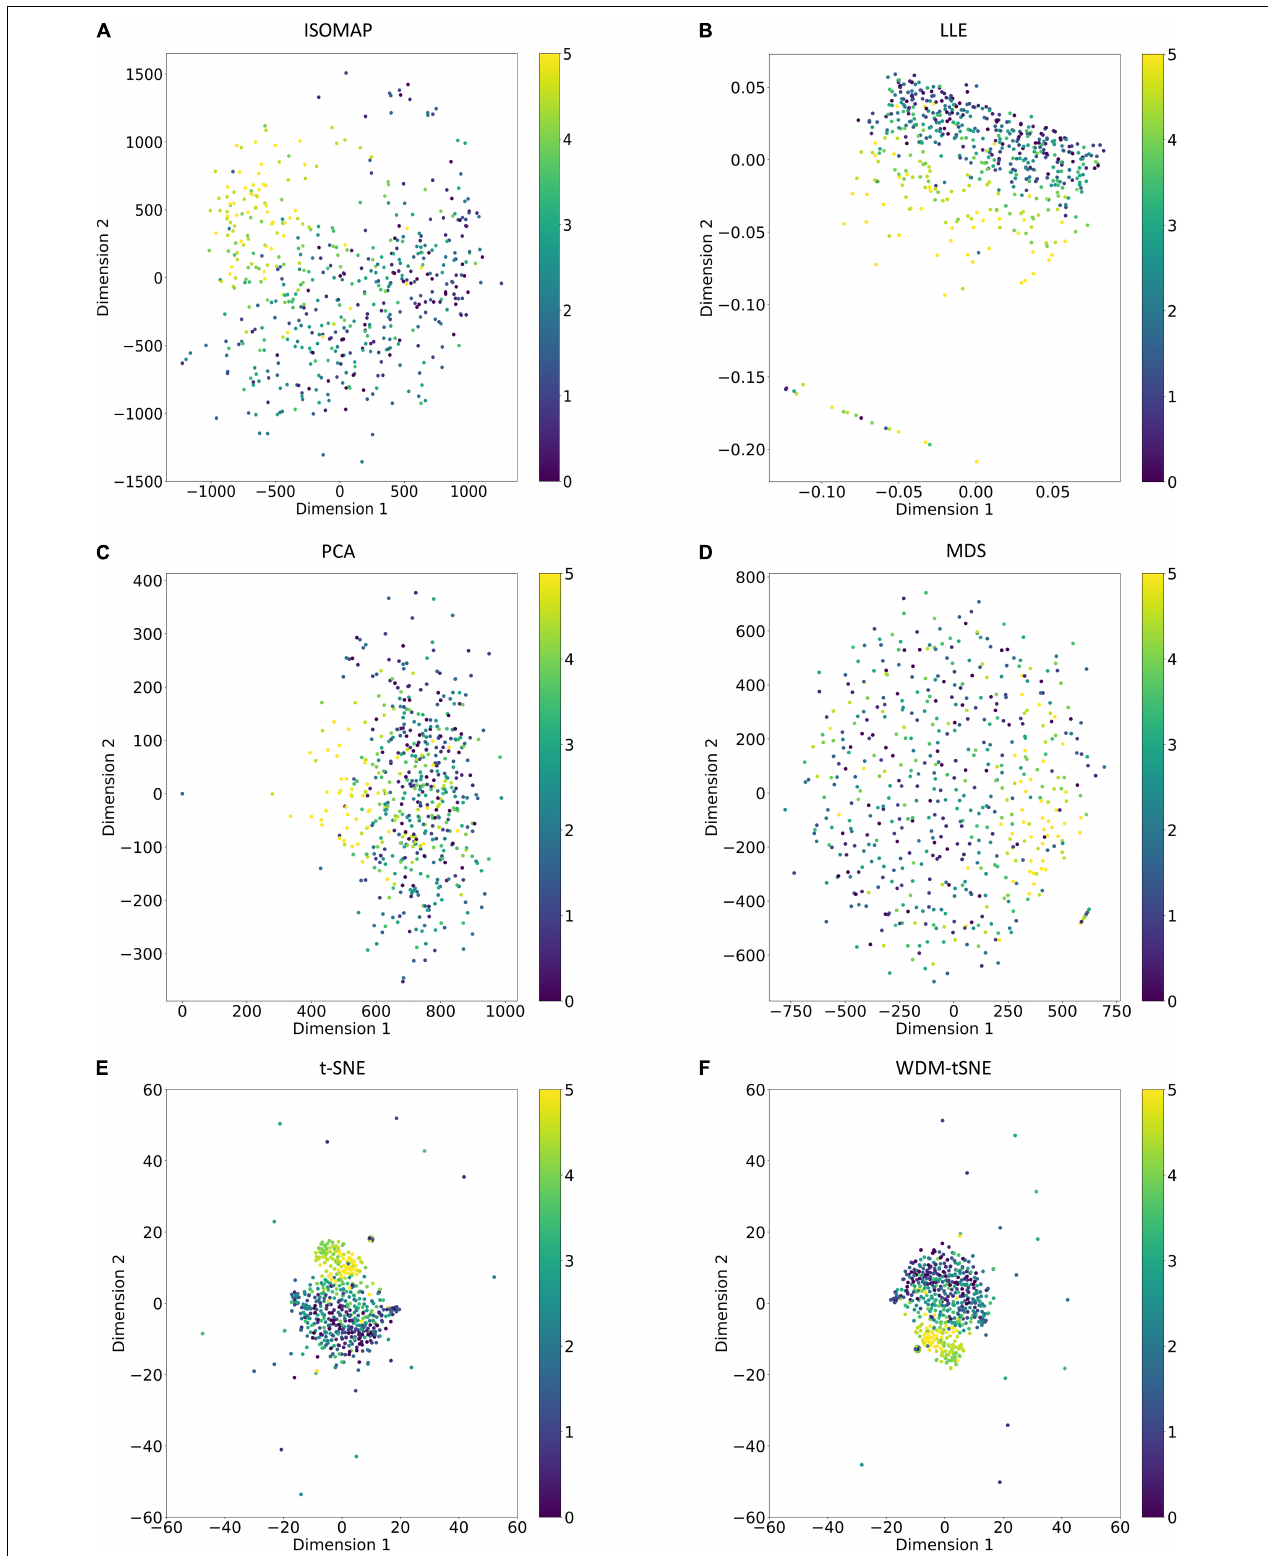
FIGURE 9 | The plots for the balanced dataset of ARR based on six dimensionality reduction approaches, including (A) Isomap, (B) LLE, (C) PCA, (D) MDS, (E) t-SNE, and (F) WDM-tSNE. The samples with 11 rates were plotted. ARR, Aphanomyces Root Rot.